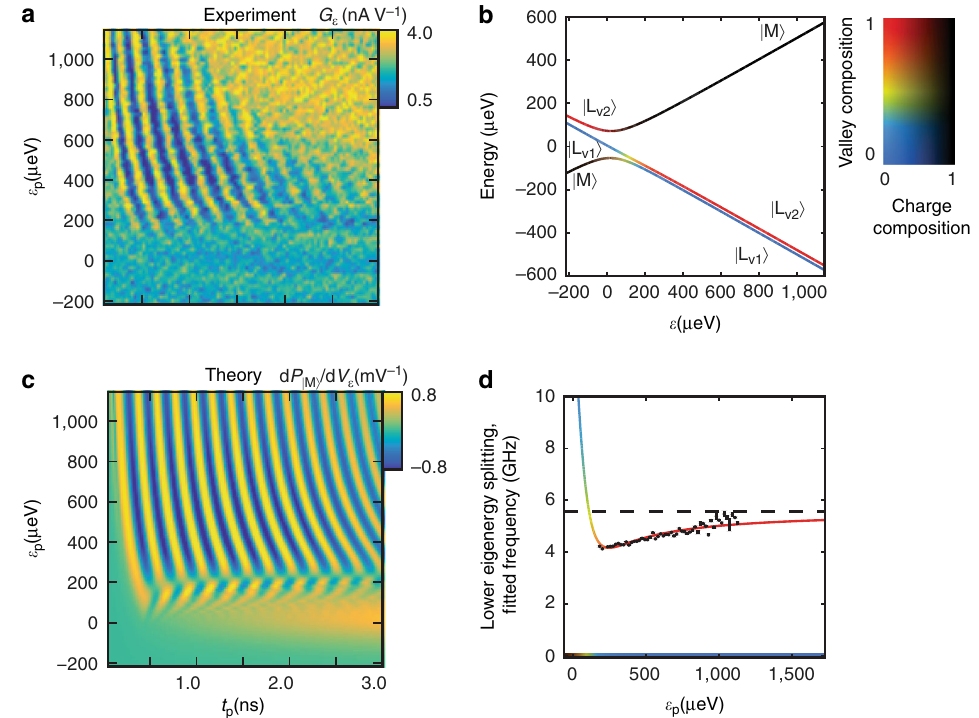
Fig. 3 Detuning dependence of oscillations. a Experimental mapping of the detuning dependence of the time domain oscillations; b Energy spectrum derived from fi tting to the extracted dispersion: A two-dimensional color bar is used to simultaneously display a state ’ s makeup in the charge degree of freedom, calculated as the probability of a state, | ψ 〉 , being in the middle dot, | 〈 ψ | M 〉 | 2 , and the valley degree of freedom, calculated as the probability hj L v2 ij j 2 of being in the fi rst excited valley state conditional upon being in the left subspace, . ( δ = 5.57GHz, Δ 1 = 6.4 GHz, Δ 2 = 13.6 GHz) c Simulated 1 (cid:3)hj M ij j 2 charge-sensing transconductance signal, obtained by solving the time-dependent Schrodinger equation without dissipation: A square pulse with a fi nite rise time of 200 ps was assumed. d Experimentally extracted frequencies plotted along with the separation between the lower two eigenenergies as a function of detuning: The extracted value of the valley splitting, δ , is plotted as a dotted line. The color of the fi tted curve is the color associated with the middle eigenstate at a detuning using the coloring from b . Along the bottom axis, the color represents the makeup of the ground